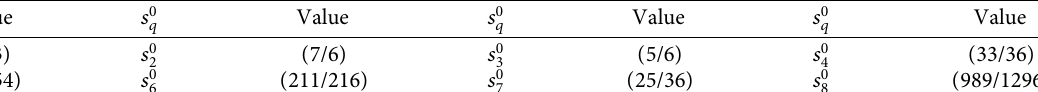
Table 2: Initial